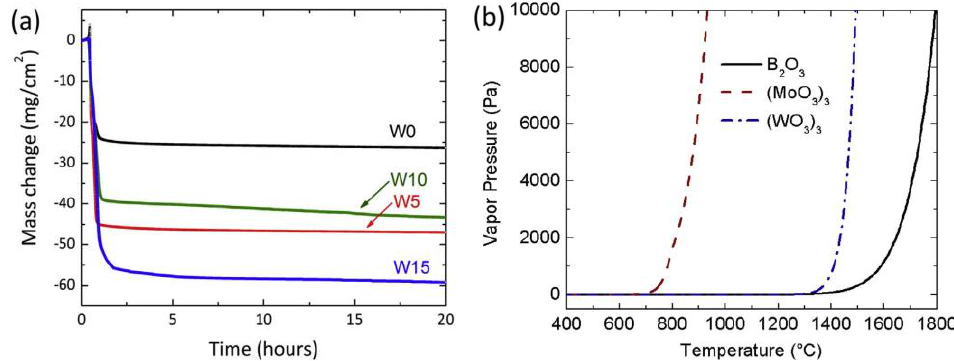
Figure 15. ( a ) Weight change curve of all samples at 1200 °C; ( b ) Variation of vapor pressure with temperatures. Reproduced with permission [70]. Copyright 2017 Elsevier.